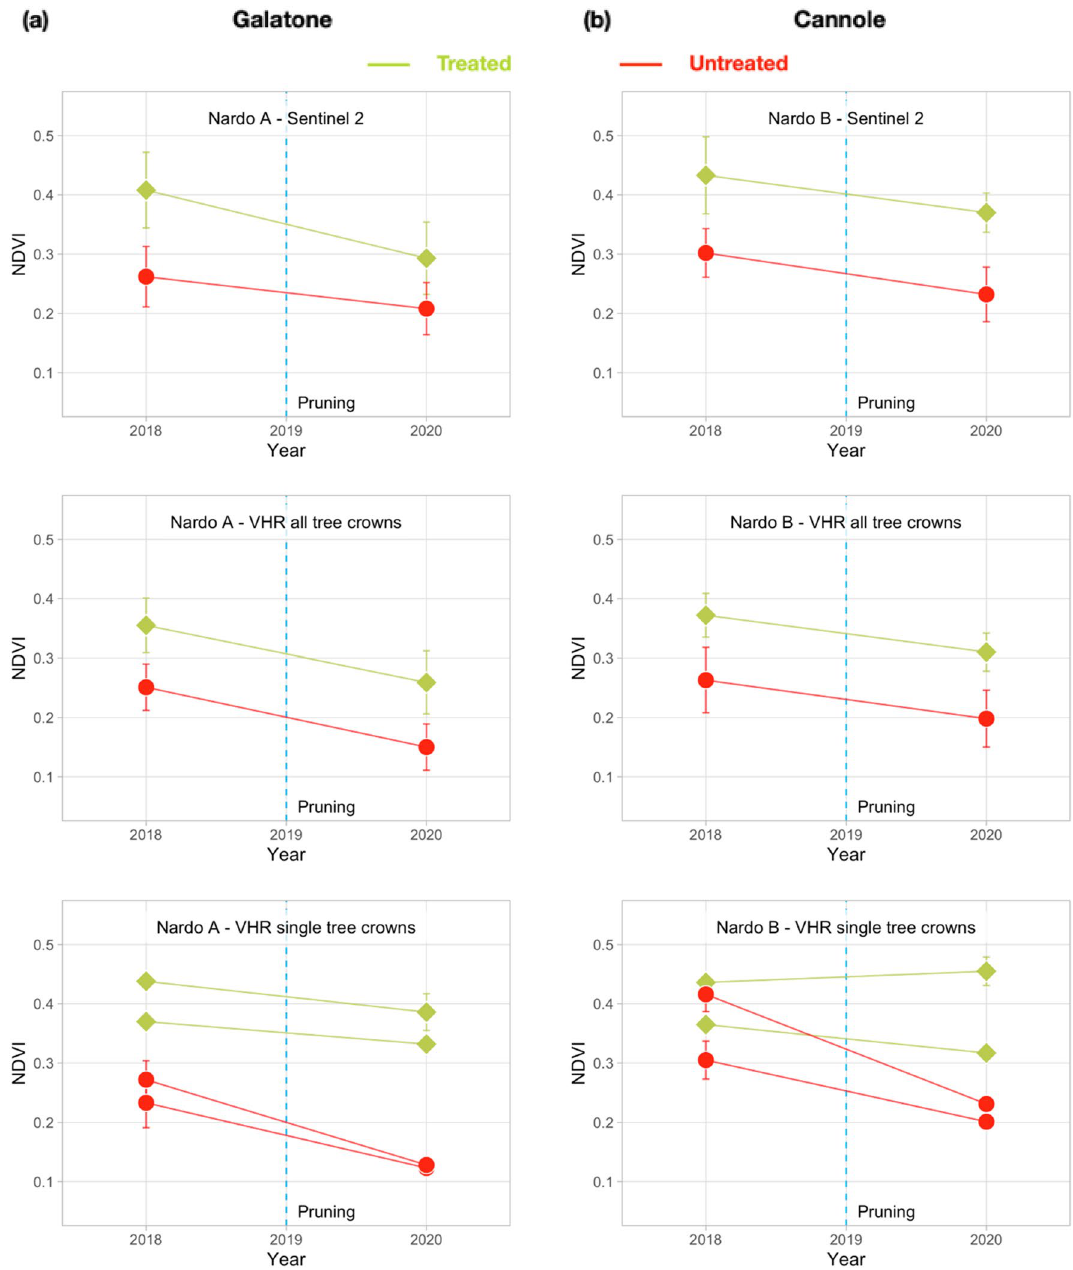
Figure 13. NDVI mean value for test fields, Nardò A (column a ) and Nardò B (column b ), same Ionian coast, from: all S-2 pixels in the field, first line; all tree crown pixels only in VHR Pléiades images, second line; tree crown pixels of different sample trees in VHR images, third